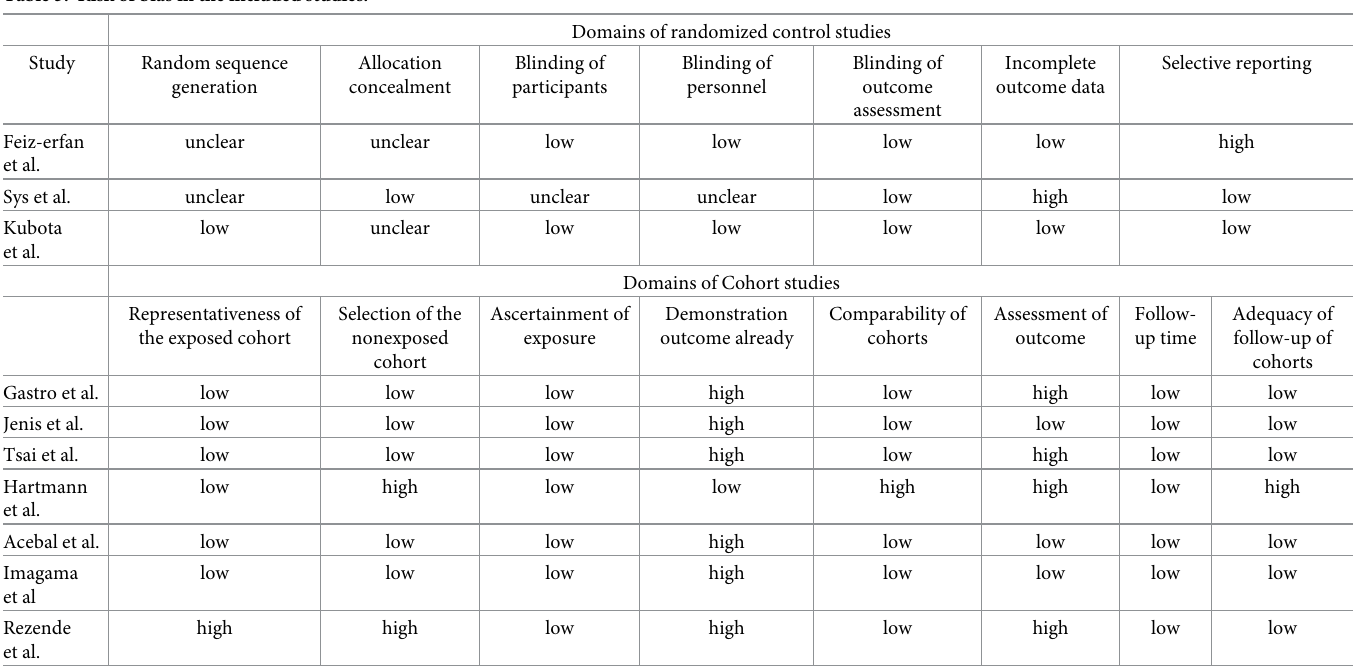
Table 3. Risk of bias in the included studies.